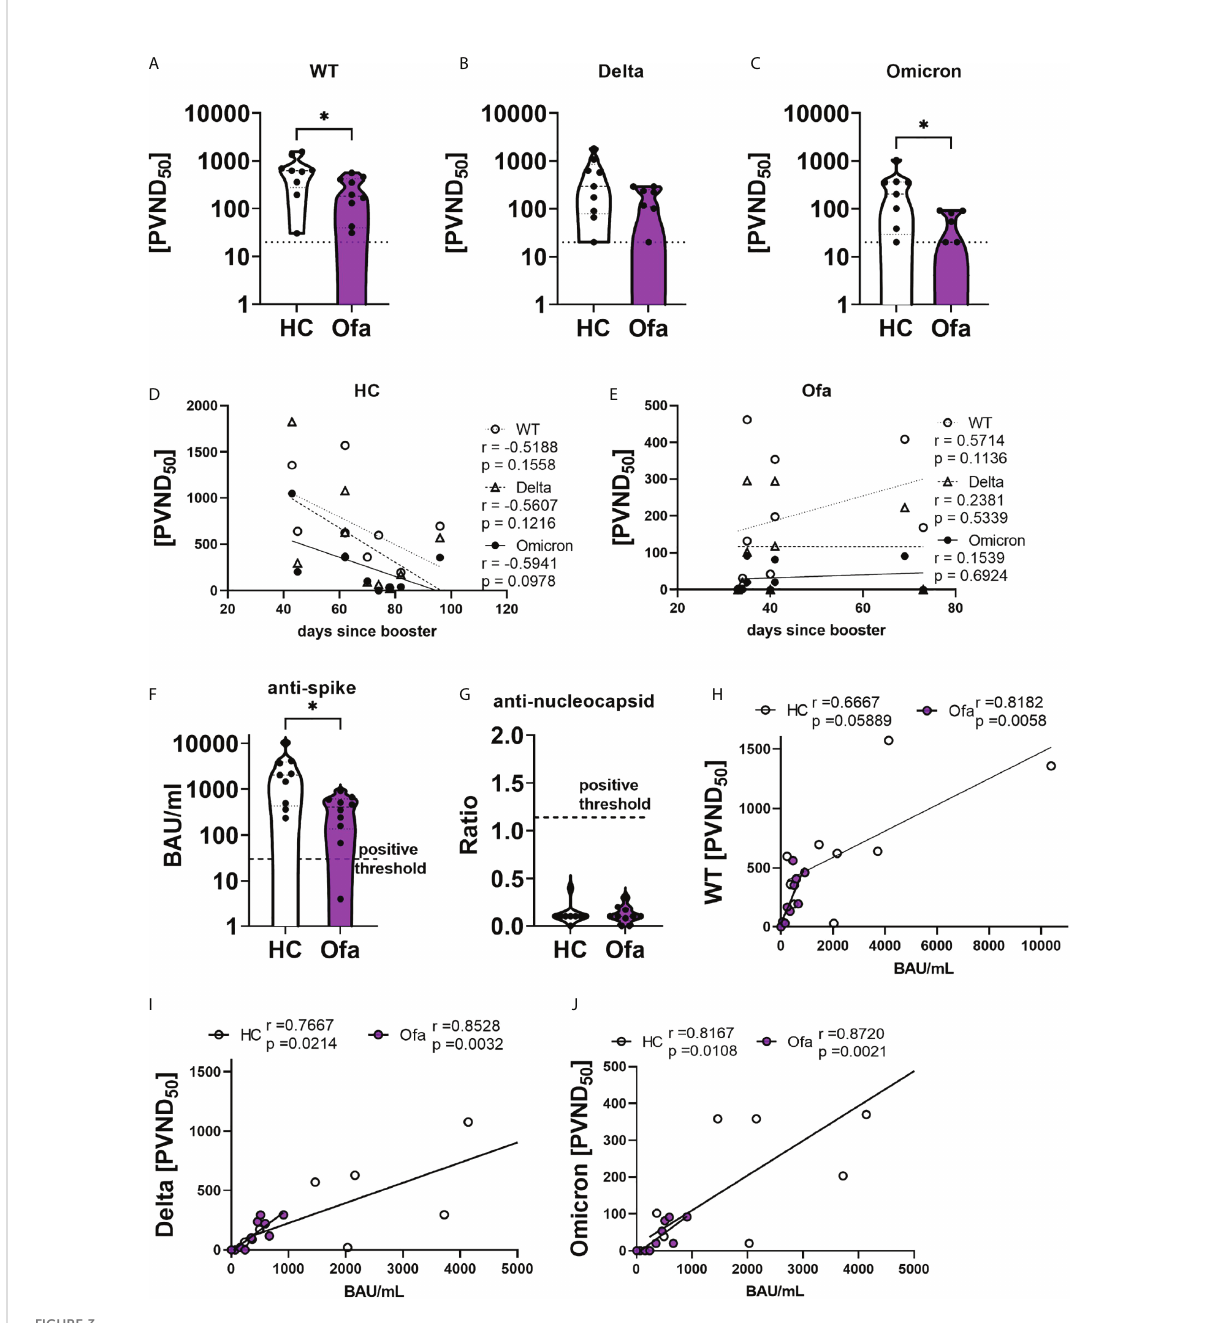
FIGURE 3 Ofatumumab treated MS patients elicit lower SARS-CoV-2 spike titers and less neutralizing capacity. Sera of Ofatumumab treated MS patients (Ofa) and healthy controls (HC) were collected 4-13 weeks following the third vaccination against SARS-CoV-2 and neutralization against SARS- CoV-2 variants and anti-SARS-CoV-2-spike titers were measured. (A – C) Sera of Ofa treated MS patients have signi fi cantly lower neutralization capacity against a) wild type (WT, p=0.0220) and (C) Omicron (p=0.0208) variants, with borderline signi fi cance against the (B) Delta variant (p=0.0677) of the SARS-CoV-2 virus compared to HC. (D) Neutralizing capacities of HCs did not depend on the number of days since the third vaccination. (E) In the Ofa group, the neutralization of the WT variant was higher the more days had elapsed since the third vaccination. The neutralization of the Delta and Omicron variant did not depend on the days since booster. (F) anti-SARS-CoV-2-spike titers were lower in Ofa patients (p=0.0172) compared to HC. (G) No patient had anti-SARS-CoV-2 nucleocapsid antibodies. The anti-SARS-CoV-2-spike titers strongly correlated with neutralization capacity against (H) WT, (I) Delta and (J) Omicron. BAU/mL: binding antibody unit per milliliter. PVND 50 : pseudovirus neutralization dose 50%. Data were analyzed with a two-tailed Mann-Whitney U test and Spearman correlation. n=10 Ofa, n=9 HC.